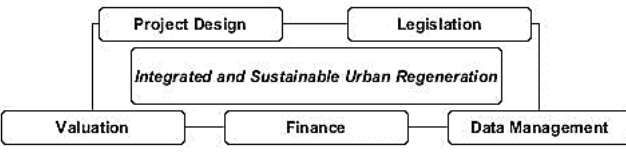
Figure 2. Components of Integrated and Sustainable Urban Regeneration .